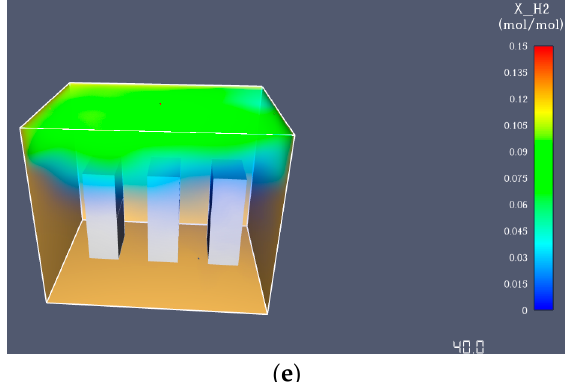
Figure 12. Full pipe rupture at the inlet of the bottom right stack with 30ACH: ( a ) detection at 1.3 s; ( b ) concentrations at 2.8 s; ( c ) concentrations at 6 s; ( d ) concentrations at 28.1 s; ( e ) concentrations at 40 s.